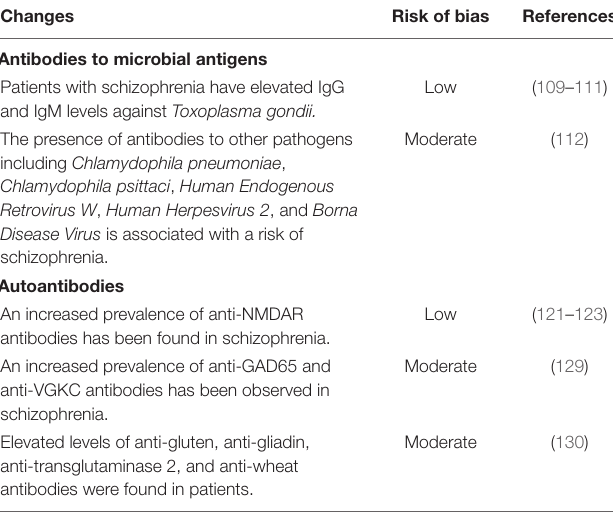
TABLE 5 | Abnormalities in the level or reactivity of antibodies in